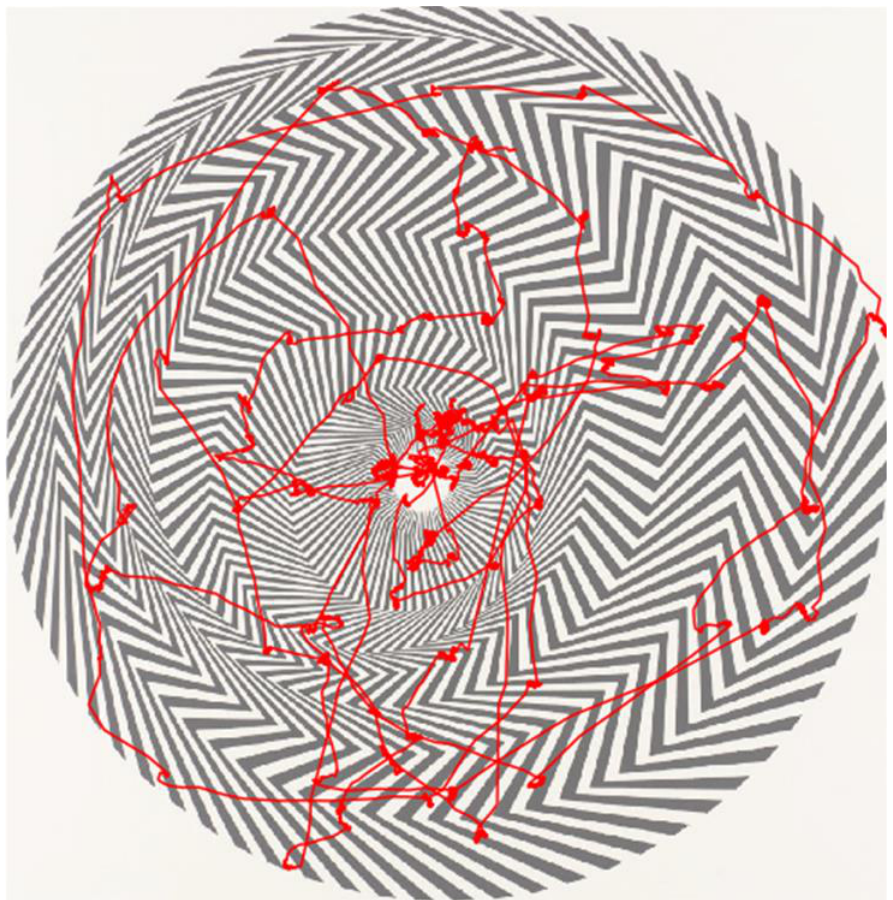
Figure 2. Example of one participant’s eye tracing over the 30 s viewing period.